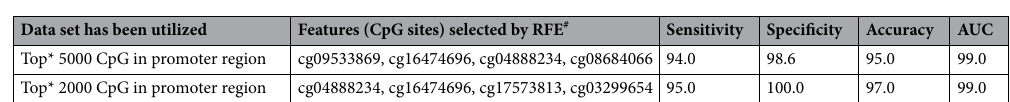
Table 1. Performance evaluation metrics for each logistic regression model to include sensitivity, specificity, accuracy and AUC for top 5000 and top 2000 CpGs in promoter (top four CpG sites selected by RFE # for model building). Top*—CpGs showing statistically the most significant change between OC cases and control subjects by p-values. # Recursive Feature Elimination (RFE).